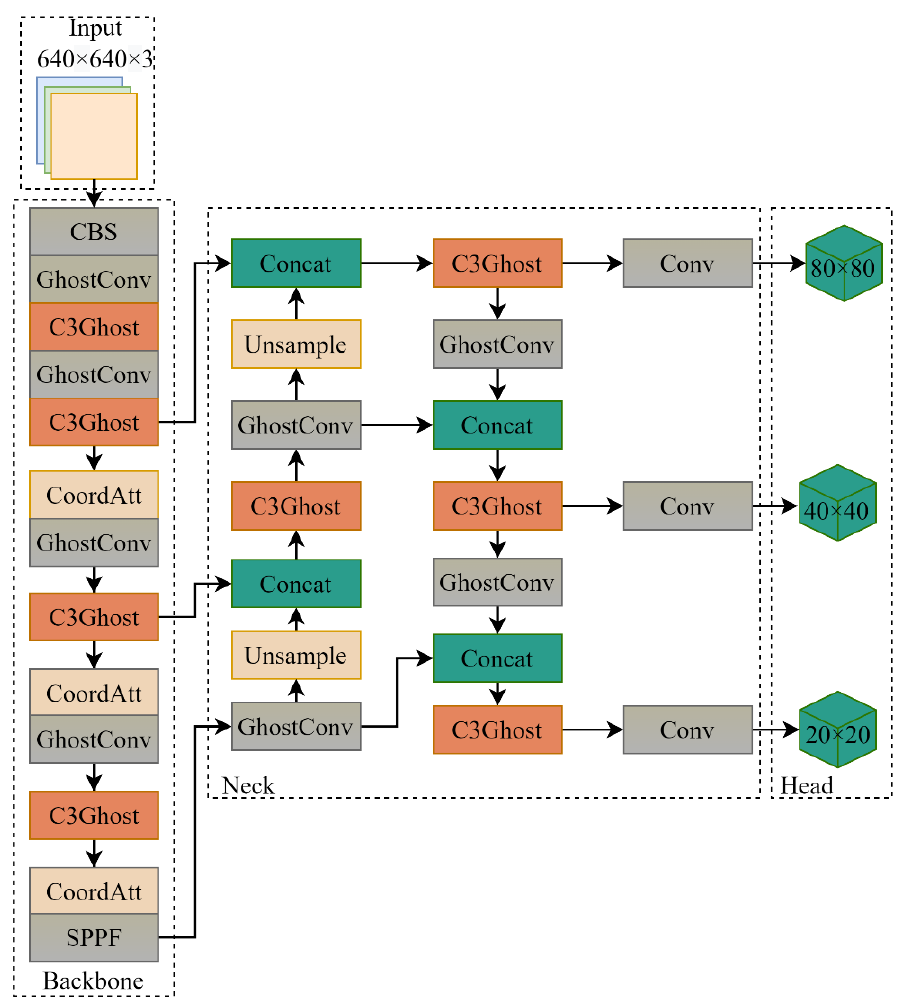
Figure 5. Structure of improved